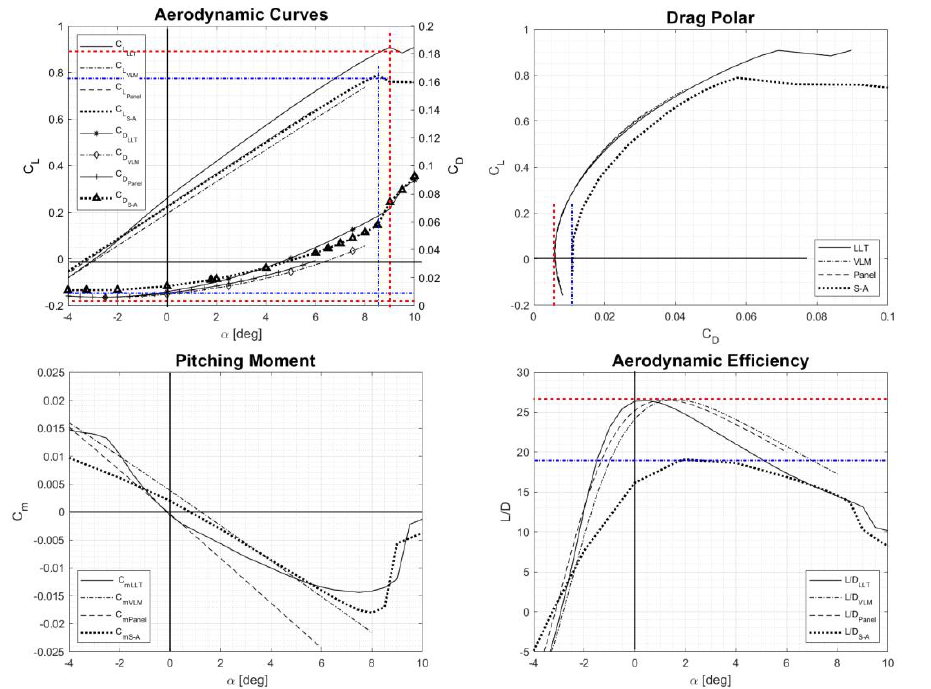
Figure 8. Aerodynamic results comparison. C L vs. α and C D vs. α ( top left ), C D vs. C L ( top right ), C m vs. α ( bottom right ), and L / D vs. α ( bottom left